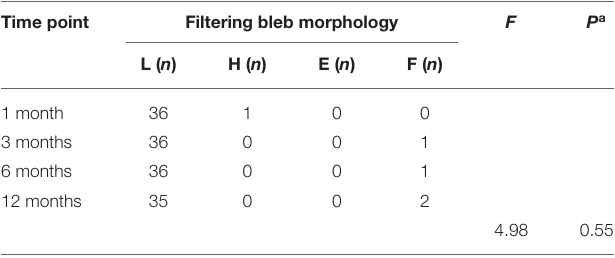
TABLE 5 | Changes in the filtering bleb morphology after